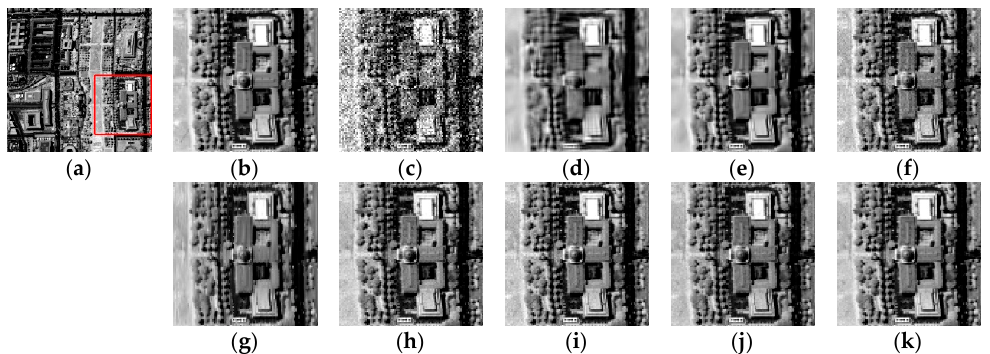
Figure 2. Denoising results for band 60 of Washington DC Mall data with Gaussian i.i.d. noise: ( a ) Clean image; ( b ) zoomed area of clean image in red box of ( a ); ( c ) noisy image; ( d ) BM3D; ( e ) BM4D; ( f ) PCA + BM4D; ( g ) KSVD; ( h ) LRMR; ( i ) NAILRMA; ( j ) BPFA; and ( k ) HyDeSpDLS.